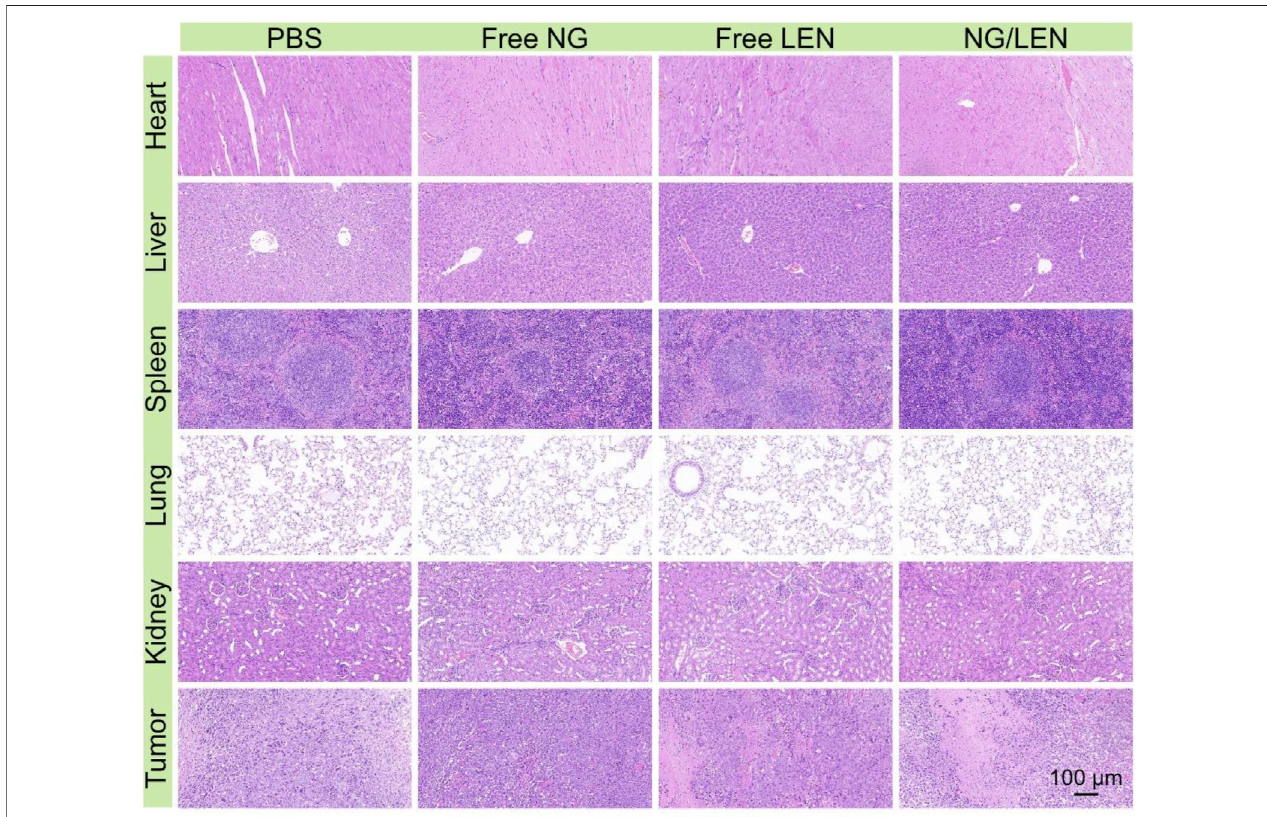
FIGURE 6 | Histopathological analysis of organ sections, i.e., heart, liver, spleen, lung, kidney, and liver tumor after treatments of PBS, free NG, free LEN, or NG/ LEN toward subcutaneous HCC tumor model.